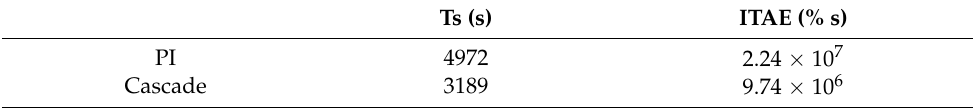
Table 4. Settings of the controllers from Figure